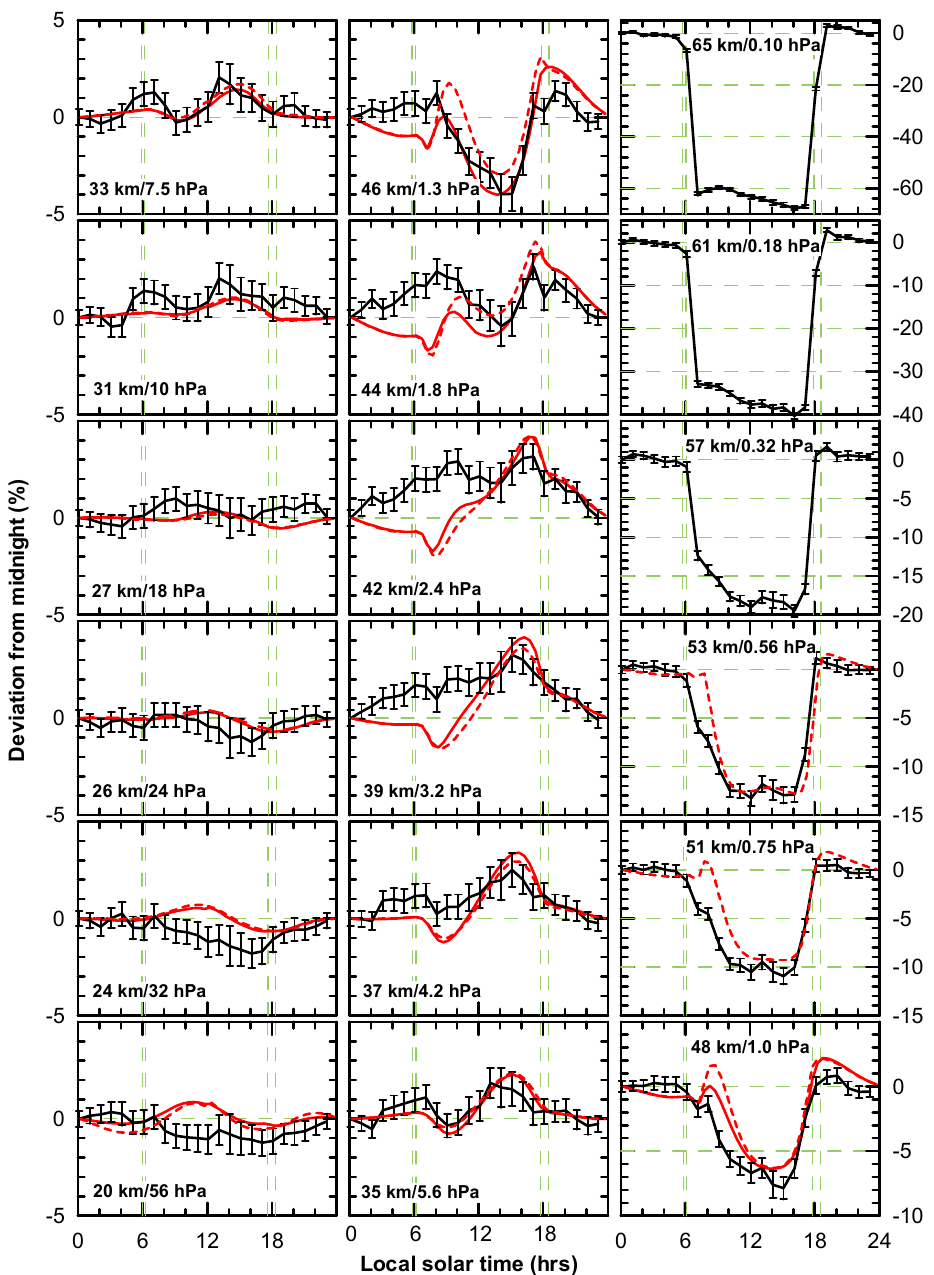
Figure 9. Measured and modeled ozone values as in Fig. 8 except for winter (January, February, and March).